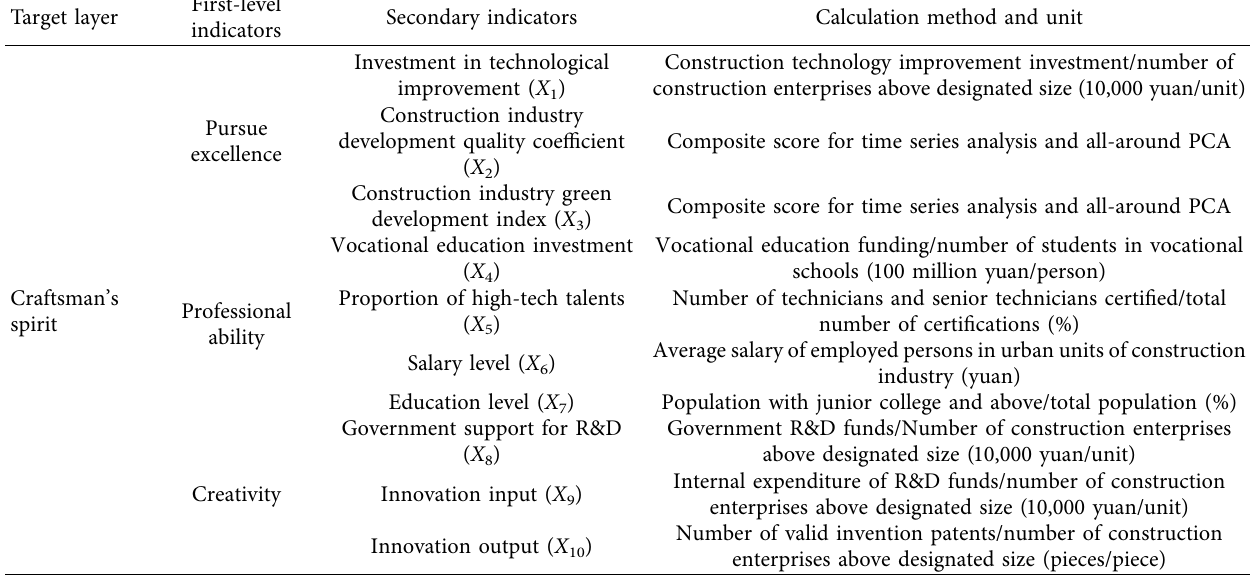
Table 1: The comprehensive evaluation index system of craftsman’s spirit in the construction industry.